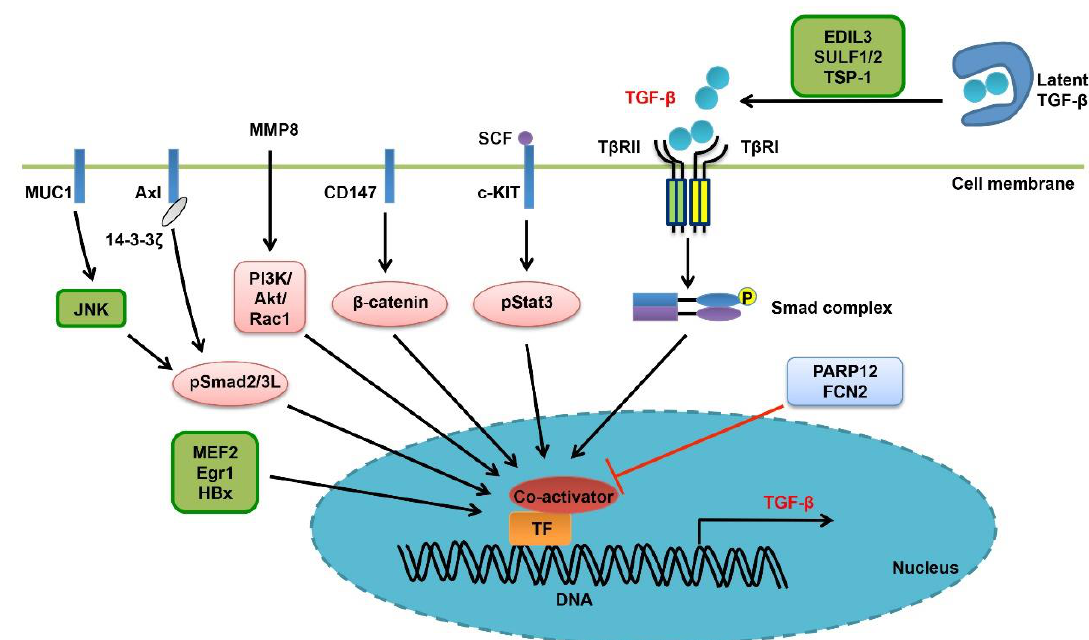
Figure 3. Bioavailability of the TGF- β ligand in liver cancer. In the resting state, the mature TGF- β ligand dimer is trapped and stored in the ECM. TGF- β is not able to associate with its cognate cell membrane receptors until activated by integrins, proteases or other proteins. EDIL3, SULF1 / 2 and TSP-1 are involved in this process. Some extracellular factors and membrane receptors, such as SCF / c-KIT, Axl, CD147, MUC1 and MMP8, are able to induce TGF- β gene expression through di ff erent intracellular pathways. TGF- β expression is also under the control of TGF- β / Smad signaling, forming an autoregulatory loop. In addition, some other proteins like MEF2, Egr1, HBx, PAPR12 and FCN2 may regulate TGF- β transcription either positively or negatively.